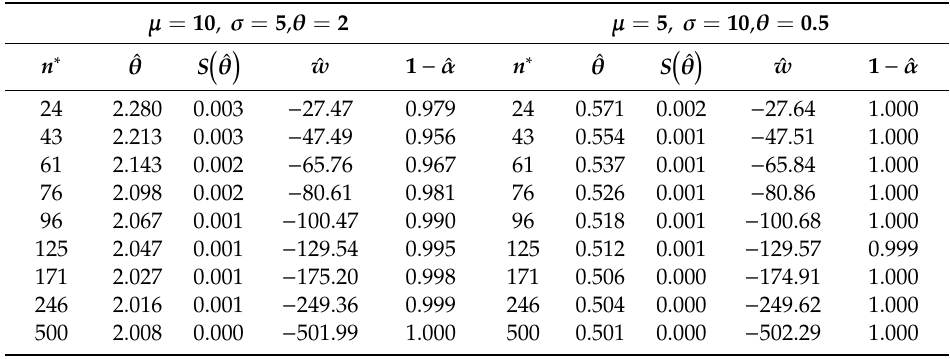
Table 3. Three-stage estimation of the inverse coe ffi cient of variation under a unified stopping rule. µ = 10 , σ = 5 , θ = 2 µ = 5 , σ = 10 , θ =